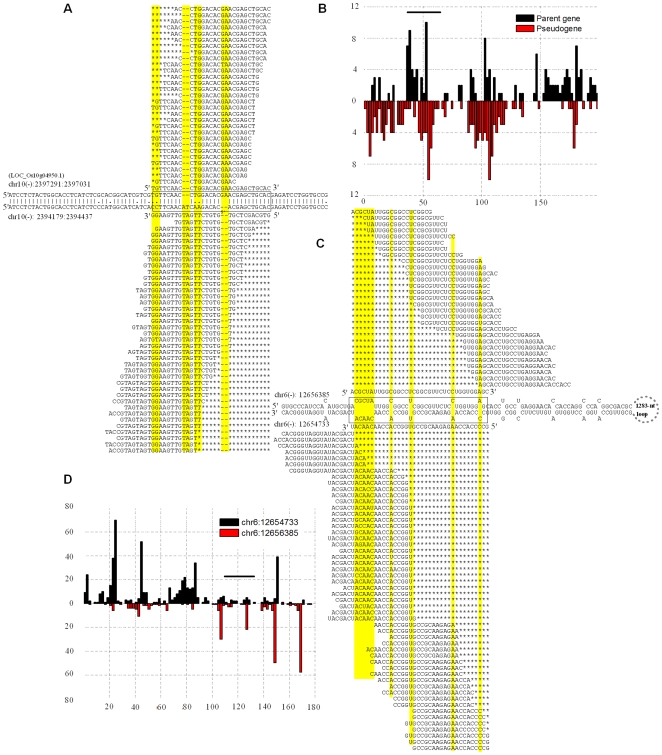
Examples of regulatory small RNAs derived from pseudogenes.One (A, B) is for gene-pseudogene interaction and the other (C, D) is from a pair of inverted pseudogenes forming predicted RNA duplex. The numbers of small RNAs mapped unambiguously to the top strand (in black) and the bottom strand (in red) are shown in B and D, and the counts are for small RNAs with their starting positions located in a 2-bp bin. Data in the top and bottom of A and B are for the gene (sense) and its pseudogene (antisense), respectively, while the data in the top and bottom of C and D are for a pseudogene and its paralogous pseudogene on the opposite strand. Unique small RNAs from the boxed regions are listed in A and C with yellow columns highlighting unique sites or indels for placing siRNAs specifically to top or bottom sequences.